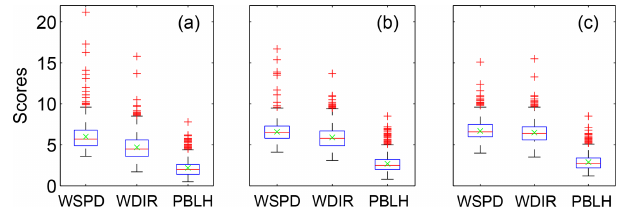
Figure 3. Box plot of the rank-histogram scores of the different sub-ensembles of 10 (a) , 8 (b) and 5 (c) members accepted by the SA. Each figure shows the rank-histograms scores for the different variables: PBL wind speed (WSPD), PBL wind direction (WDIR) and PBLH. The top of the box represents the 25th percentile, the bottom of the box is the 75th percentile, the red line in the mid- dle is the median and the green “ x ” the mean. Outliers beyond the threshold values are plotted using the “ + ” symbol.